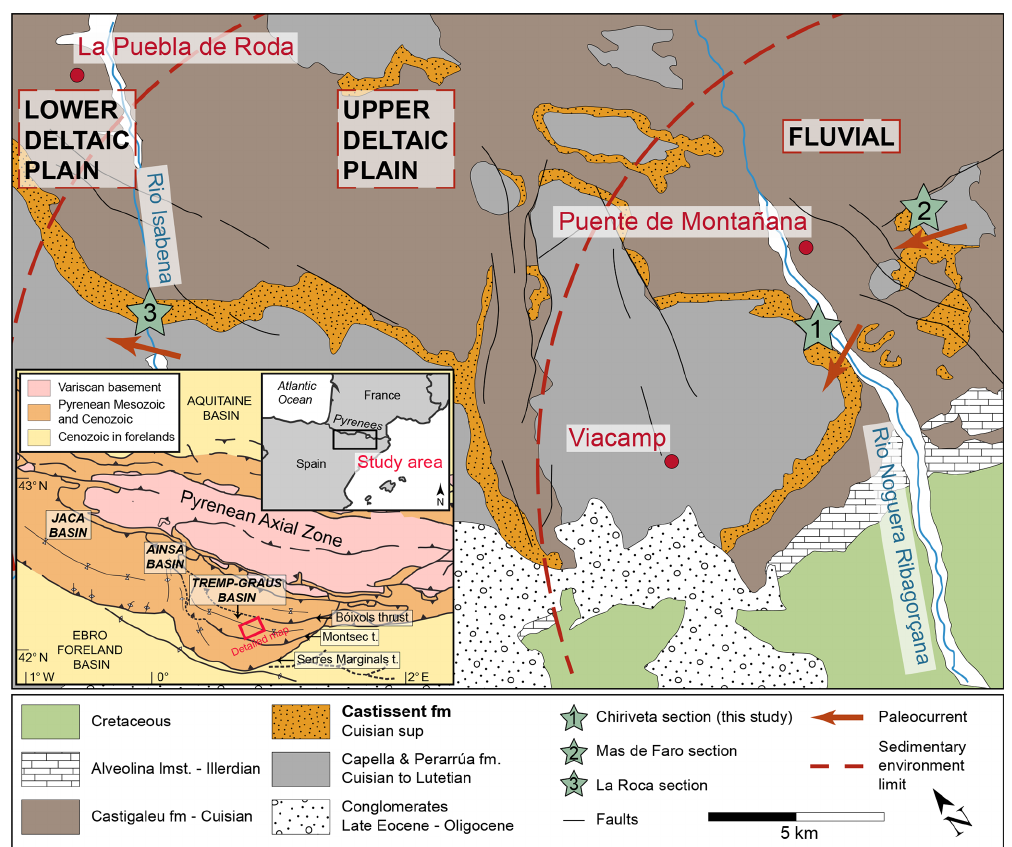
Figure 2. Simplified situation and geological map of the study area with main depositional palaeo-environments (e.g. Nijman, 1998). The Castissent Fm. is a prominent fluvial unit particularly well exposed in the Noguera Ribagorçana and Isáabena river valleys. (1) Chiriveta section (2) Mas de Faro (3) La Roca section. Main palaeoflow directions indicated in orange (from Nijman and Puigdefabregas, 1978). Regional map after Teixell